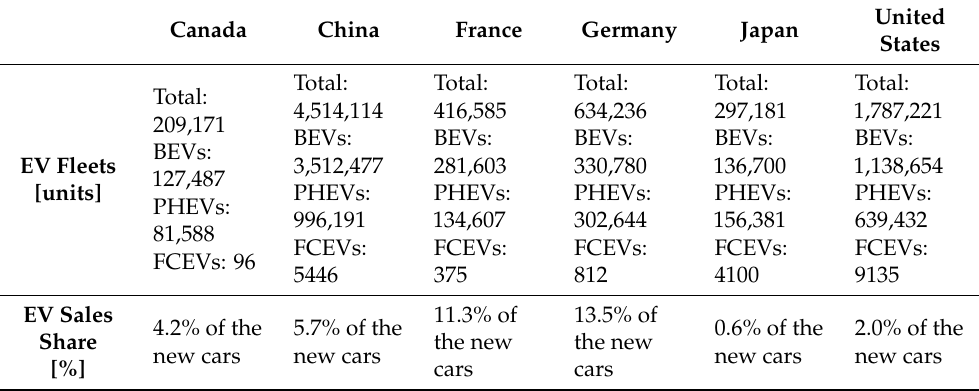
Table 2. EV market status of some